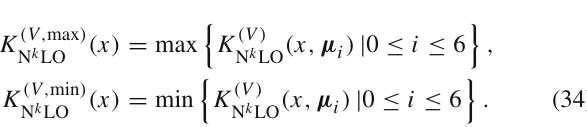
Fig. 5 Shape variation function ω shape ( p T ) defined in Eq. (36)